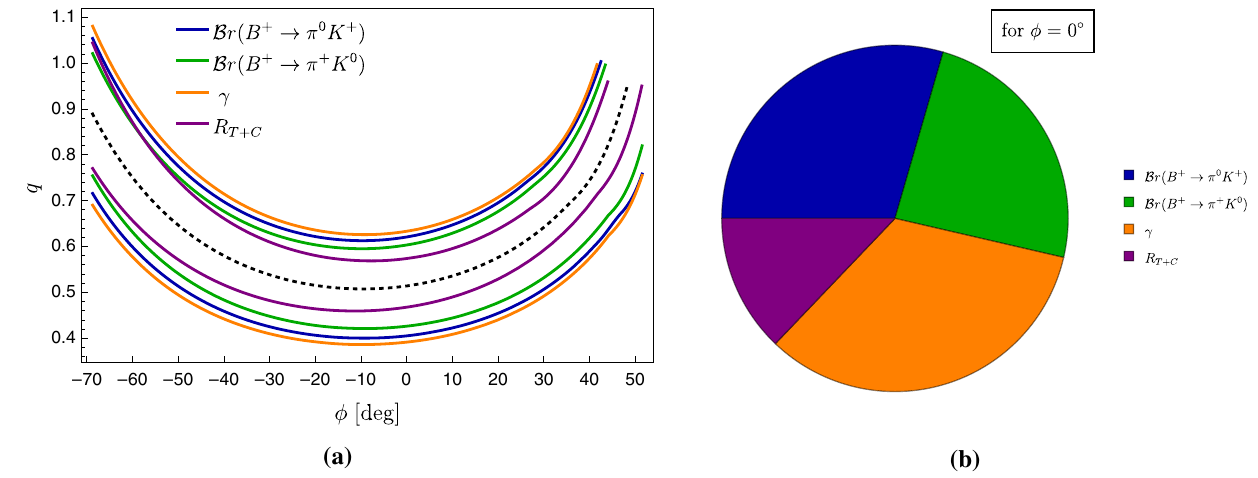
pie chart to illustrate the relative contributions of the parameters to the total uncertainty of q for φ = 0